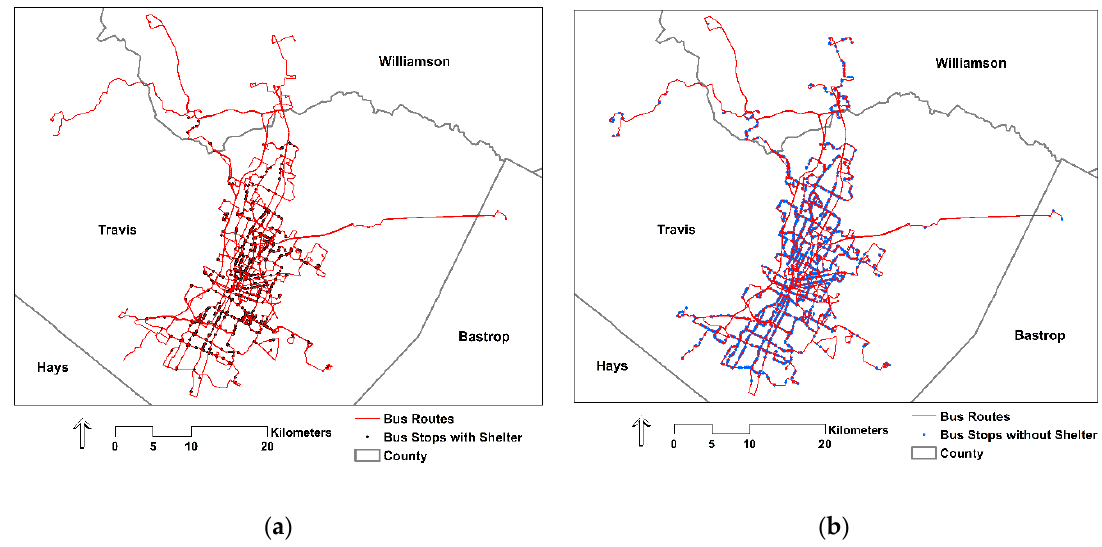
Figure 1 . ( a ) Capital Metro bus stops with shelter (n = 661); ( b ) Capital Metro bus stops without shelter (n =